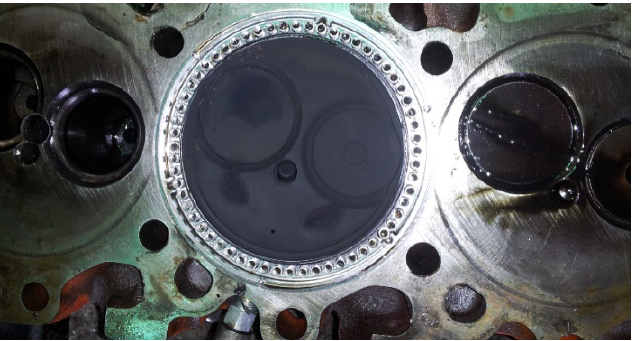
Figure 7. Cylinder head, showing the head insert that houses the primary sealing ring, springs that pre-load the primary sealing ring, and secondary seal.